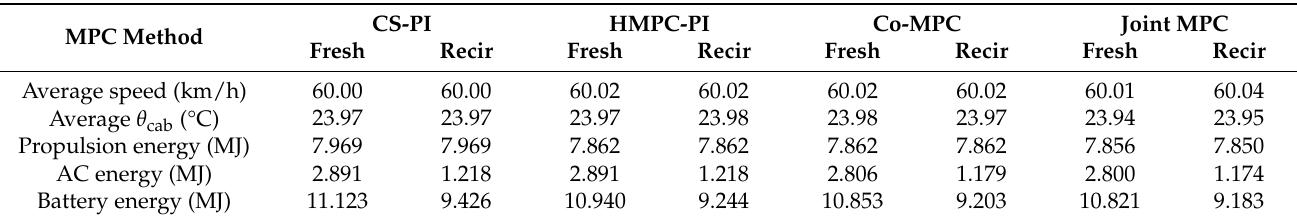
Table 3. Performance of the four methods in the first case